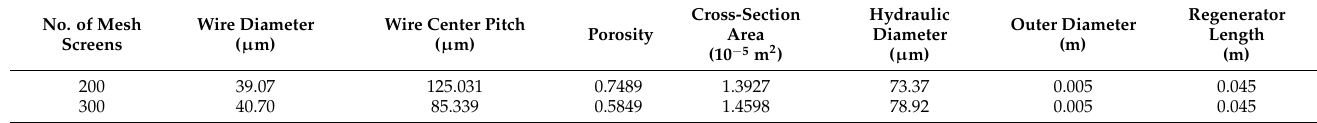
Figure 3. Regenerator fix block.